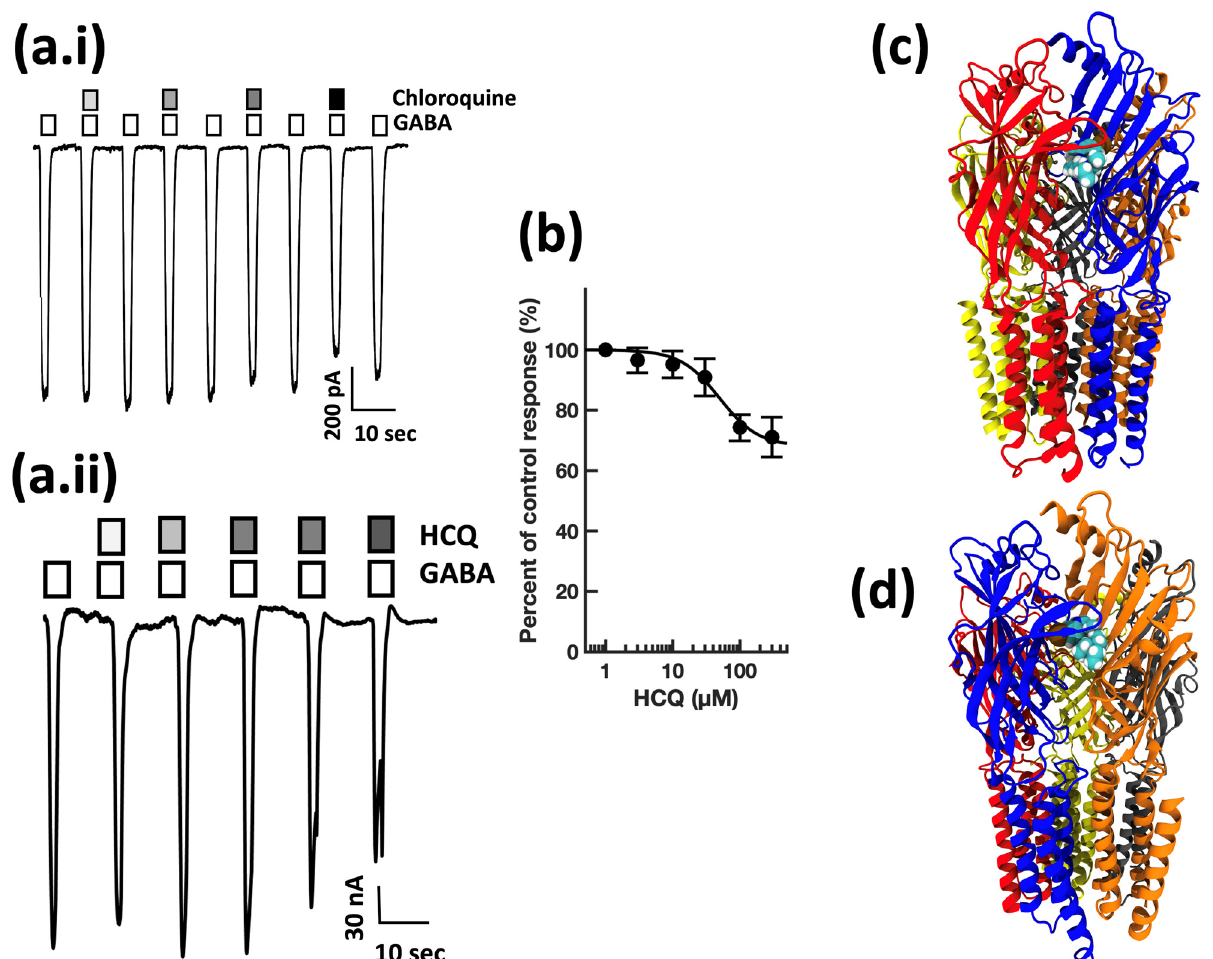
binding pocket is predicted to be defined by the lumen-facing residues of the BAE chains ( βαβ sub- units). ( d ) The rifampicin binding pocket is predicted to be defined by lumen-facing residues of the BAED chains ( βαβγ subunits). Color key: α subunit (red and grey), β subunit (yellow and orange), γ subunit (blue).